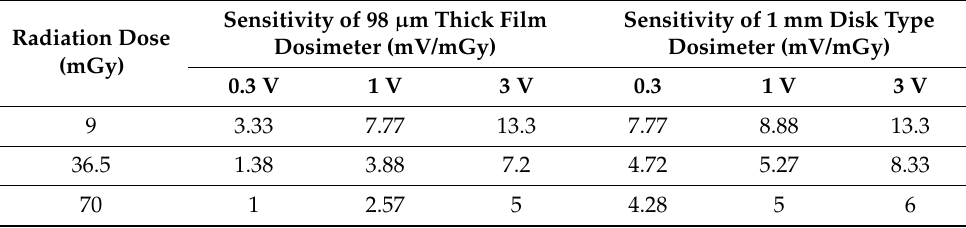
Table 1. The sensitivity of thick film and disk type dosimeters exposed to different radiation doses under an applied gate bias voltage (0.3, 1 and 3